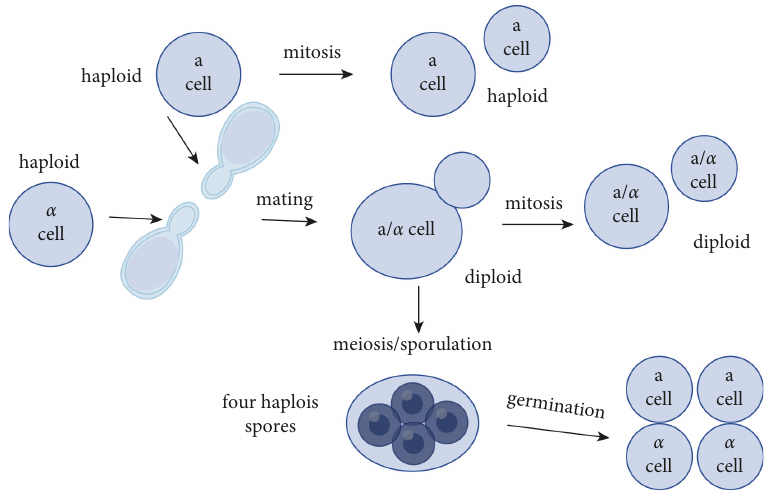
Figure 2: The life cycle of budding yeasts.